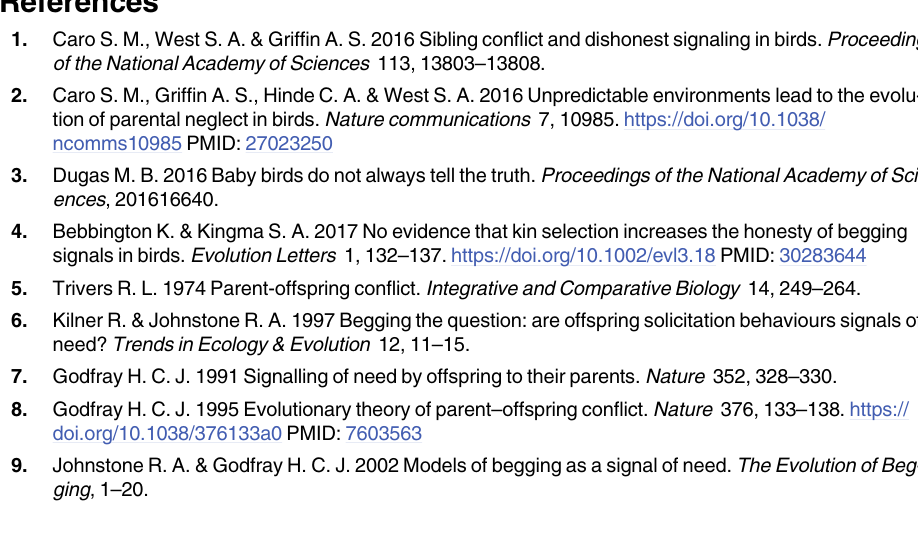
S1 Notebook. Interactive figure as Mathematica notebook. S1 Video. Video of interactive